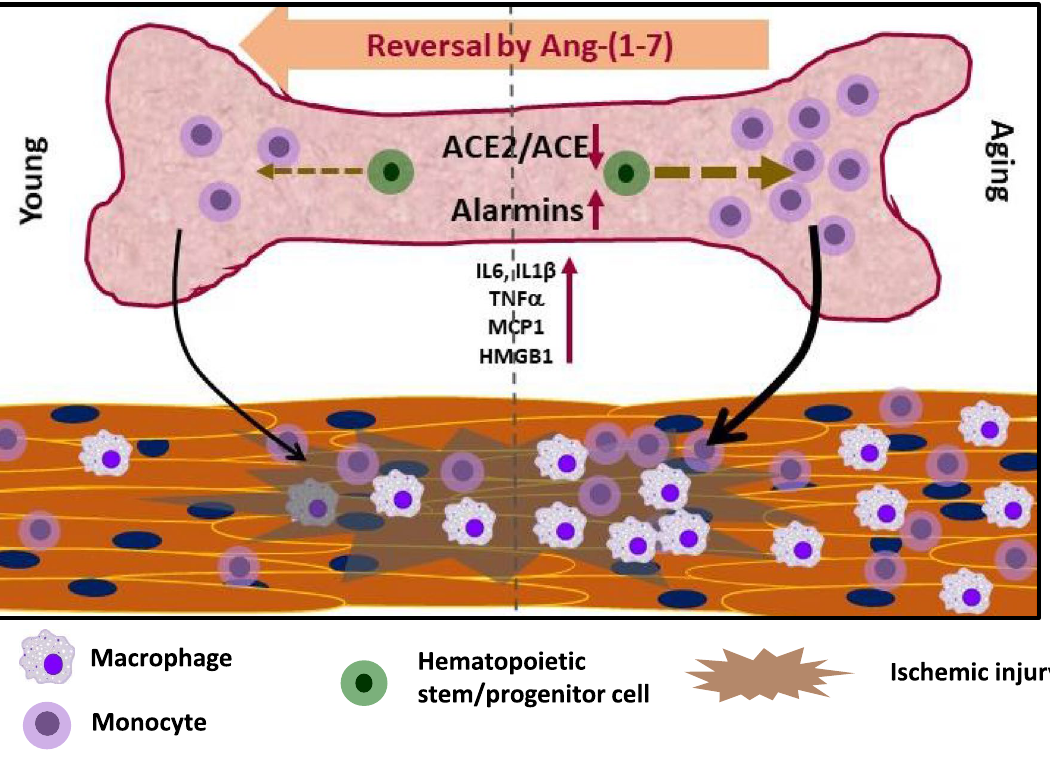
Figure 8. Summary of findings. Aging in mice is associated with imbalance in ACE2/ACE in the BM-environment and increased myelopoiesis and alarmin expression in the hematopoietic progenitor cells. Increased generation of monocyte-macrophages resulted in systemic inflammation and tissue infiltration of monocyte-macrophages. Recruitment of macrophages to areas of ischemic injury was higher in the Old mice, which resulted in impaired recovery. Ang-(1–7) via activation of MasR reversed aging-associated changes in alarmin expression, myelopoiesis and recruitment of monocyte-macrophages following ischemic and another cohort of mice was used for obtaining BM supernatants and peripheral blood samples. BM super- natants were collected by harvesting the whole bone marrow from two femurs and tibiae of each mouse in PBS. The BM suspensions were centrifuged at 1200 g and the cell-free supernatants were collected and concentrated to 0.5 mL by using Amicon centrifugal filters (3 kDa molecular weight cutoff) (Millipore Sigma). Supernatants were preserved at − 80 °C for analysis. Hind–limb Ischemia (HLI) was induced in mice by femoral artery ligation followed by excision as described before 67 . Blood-flow in the hind-limbs was measured by imaging the flux (blood × area −1 × time −1 ) by using a Laser Doppler imaging system (Moor Instruments Inc.) under isoflurane anesthesia and was reported relative to the mean blood flux in the contralateral non-ischemic limb. Isolation of bone marrow cells.